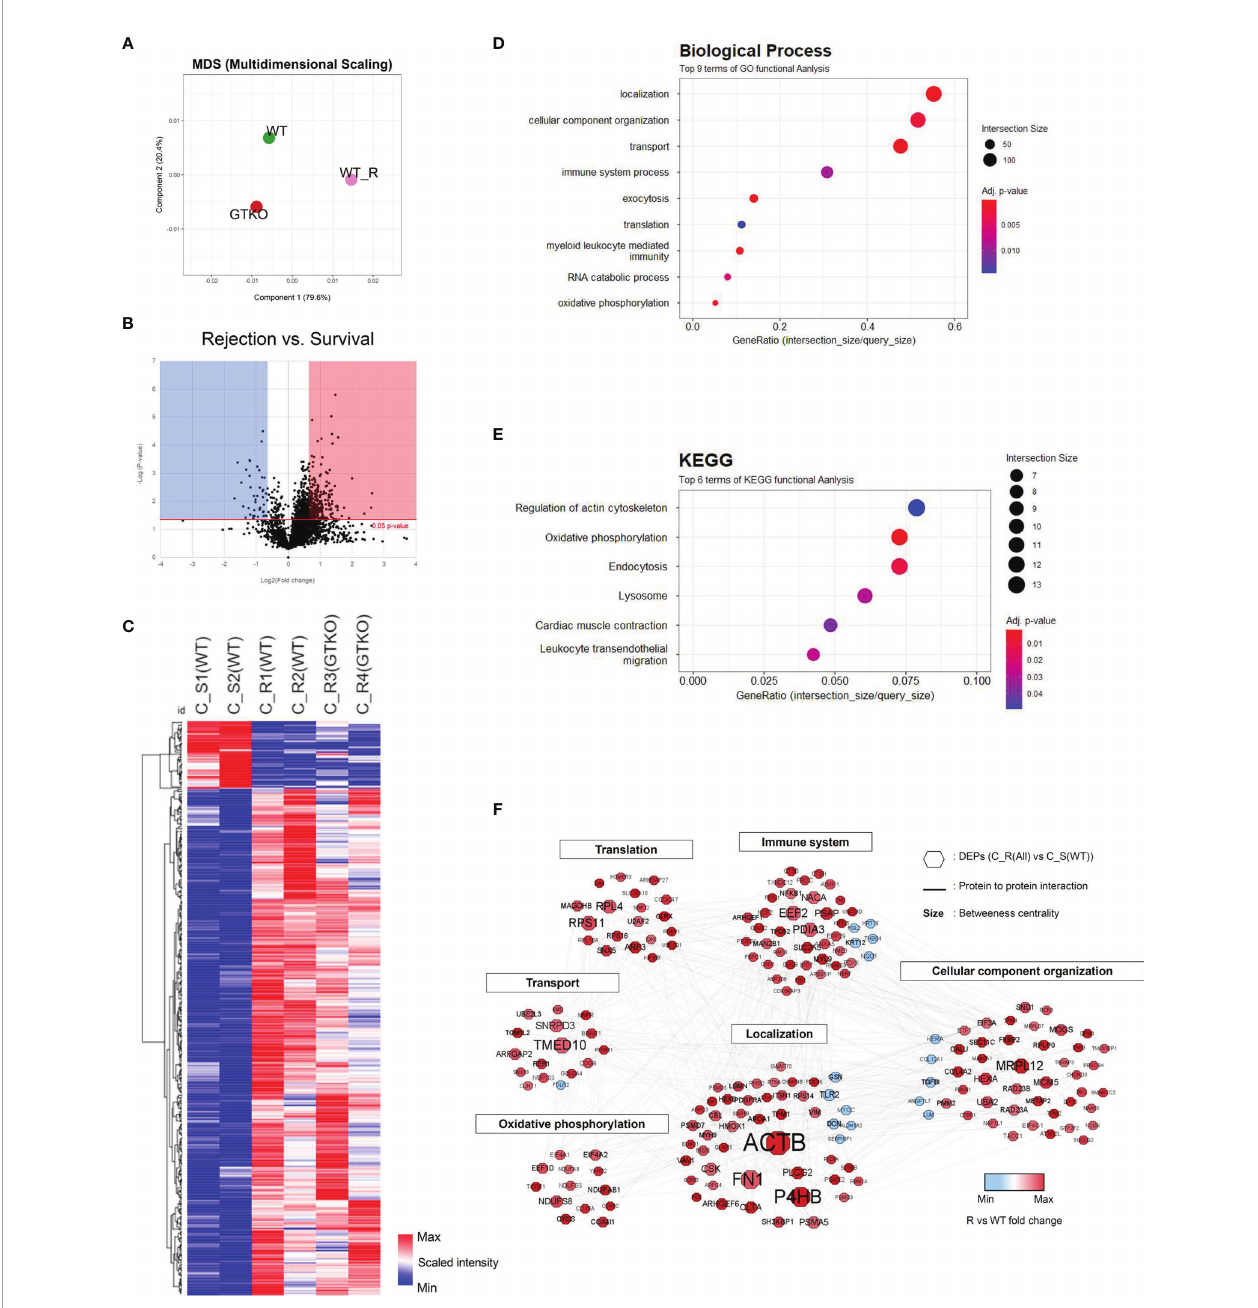
FIGURE 3 | Proteomic analysis of the corneal tissues using a non-human primate ( Macaca mulatta ) library. Proteins with at least 1.5-fold signi fi cant ( p < 0.05) changes in the rejection (R) groups [compared with the survival (S) group] were analyzed. (A) Principal component analysis of corneal tissue protein expression in the wild-type (WT) porcine cornea transplant group with rejection [C_R(WT)] or without rejection [survival; (C_S(WT)] and a -1,3 ‐ galactosyltransferase gene ‐ knockout (GTKO) porcine cornea transplant group with rejection [C_R(GTKO)]. (B) A volcano plot showing the differential level of proteins in the R group compared with the S group. (C) Cluster heat map of DEPs identi fi ed in corneal tissue. (D, E) Gene Ontology biological process classi fi cation (D) and Kyoto Encyclopedia of Genes and Genomes (KEGG) pathway enrichment analyses (E) of the DEPs in corneal tissue. Node size represents the gene ratio; node color represents the adjusted p -value. (F) Network modeling of the DEPs in corneal tissue. The network model showing the biological processes affected, including the immune system, cellular component organization, and oxidative phosphorylation. The colors of the nodes represent proteins whose levels were greatly increased (red) or decreased (blue) in the R group compared with the S group. Large nodes indicate a high degree of connectivity (betweenness centrality) with other proteins in the model. Connections between nodes (gray lines) indicate either regulatory roles or physical interactions between